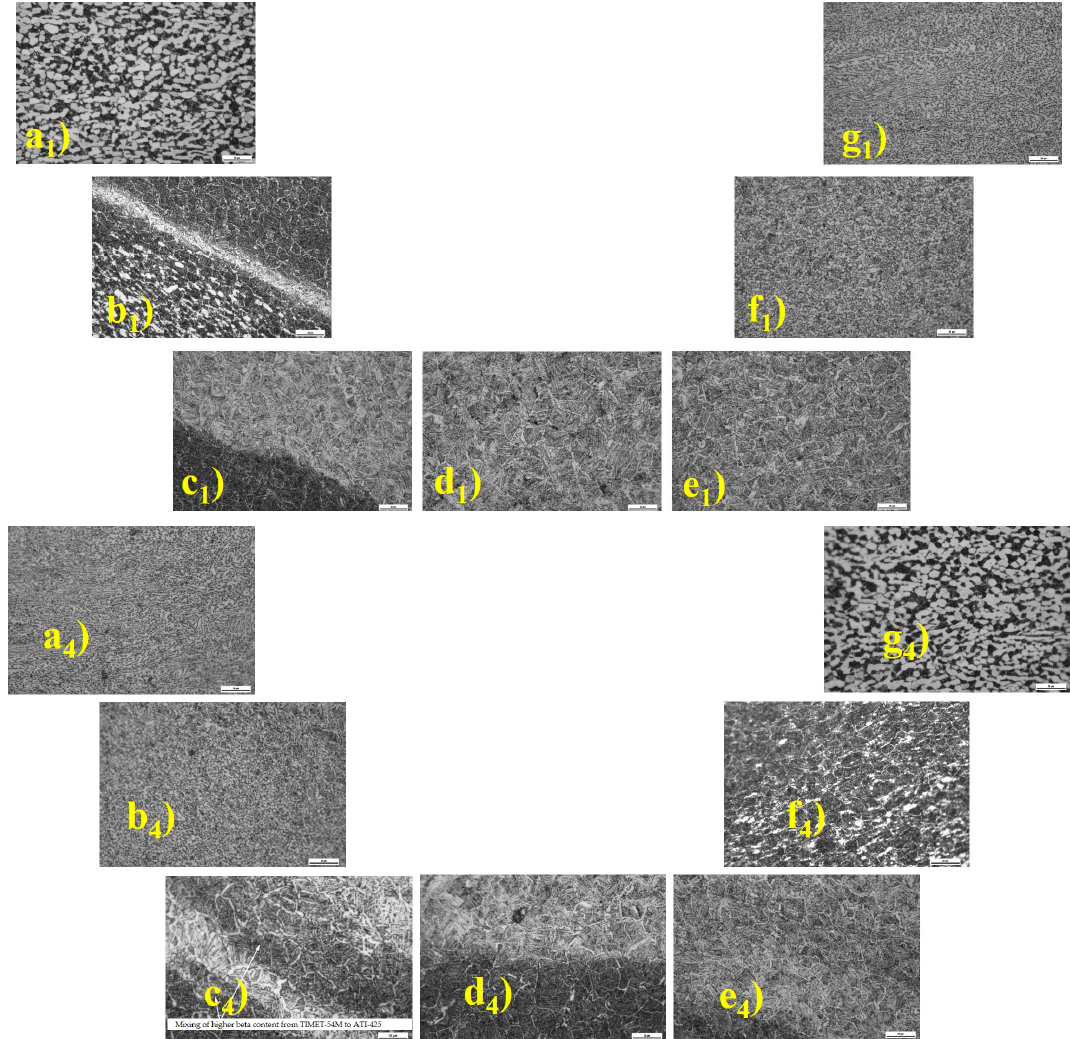
Figure 7. Optical microstructure of the specimens, P1 (marked a 1 to g 1 ), and P4 (marked a 4 to g 4 ). With a 1 , 4 being on the retreating side; and g 1 , 4 being on the advancing side. The reader is recommended to the web version for enhanced clarity of the text. Scale: 20 µm for all the micrographs except c 4 . For c 4 , the scale is 10 µm.